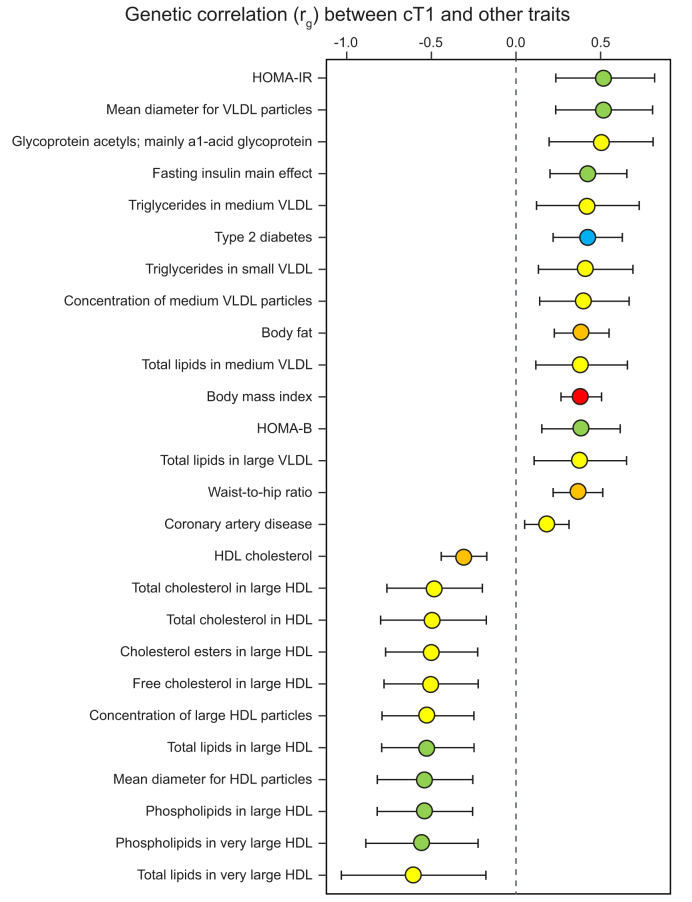
LD regression analysis.Fig. demonstrating the significant genetic correlations (rg) between cT1 and metabolic traits following correction for multiple testing (levels of significance: p false discovery rate <0.05) among more than 120 traits. The colours correspond to significance of correlation (t test); red: p <1×10−8; orange: 1×10−6 <p <1×10−5; blue: 1×10−5 <p <1×10−4; green: 1×10−4 <p <1×10−3; yellow: 0.001 <p <0.01. Higher cT1 is positively genetically correlated with VLDL, type 2 diabetes, coronary artery disease, and inversely correlated with HDL. cT1, corrected T1; HOMA-IR, homeostatic model assessment of insulin resistance, HOMA-B, homeostatic model assessment of β cell function; LD, linkage disequilibrium. (This figure appears in color on the web.)